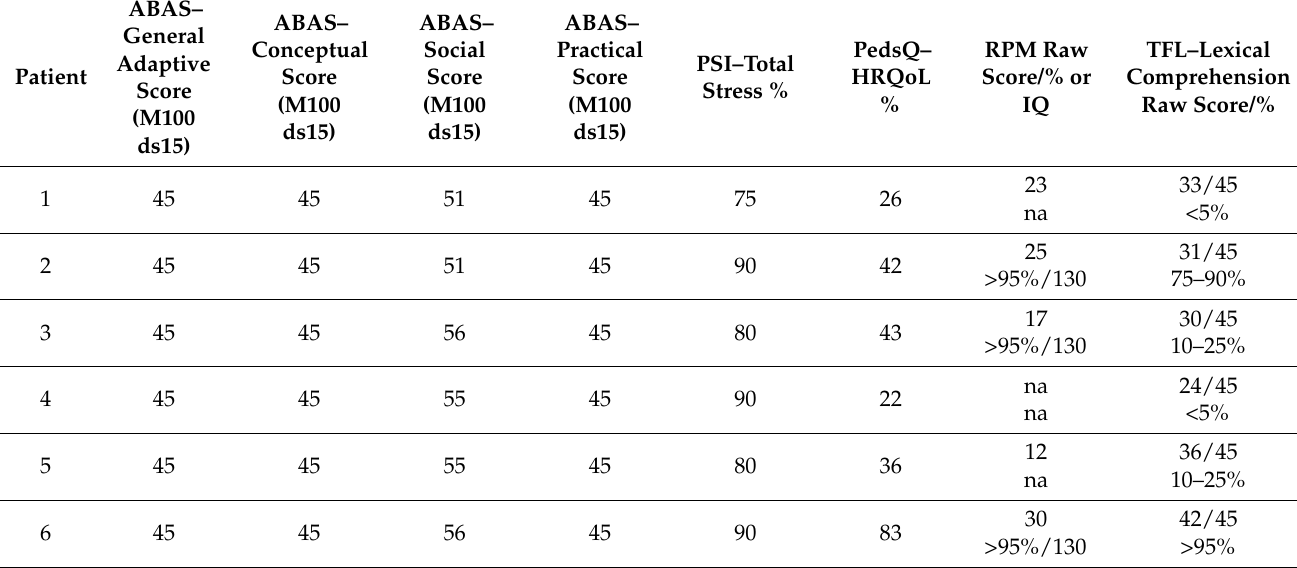
Table 2. GNAO1 cohort adaptive, cognitive, and language evaluation. ABAS: Adaptive Behavior Assessment